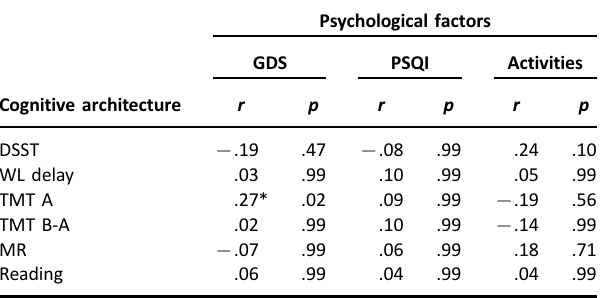
Psychological factors: Table 1 shows subjects ’ responses to